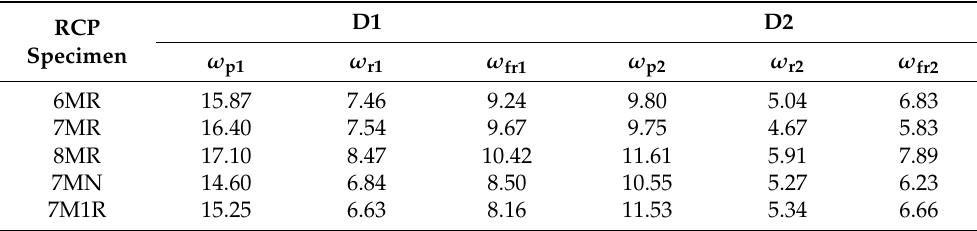
Table 8. Displacement response of all tested